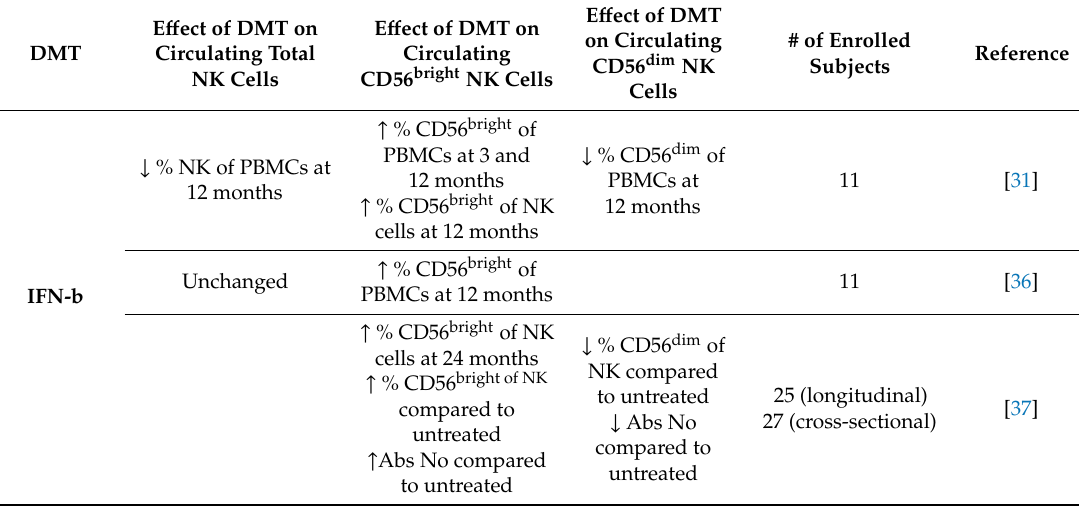
Table 1. E ff ect of disease-modifying treatments (DMTs) on natural killer (NK) cells and NK cells subsets. Each row represents a study. Abbreviations: absolute (Abs); unchanged ( = ); number (#); Peripheral Blood Mononuclear Cells (PBMCs); Interferon-beta (IFN-b); Dimethyl fumarate (DMF); Autologous hematopoietic stem cell transplantation